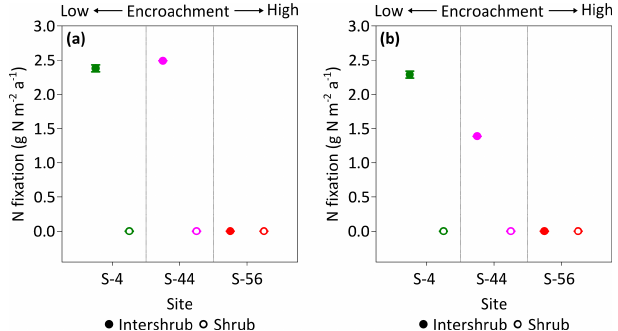
Figure 9. Median rates of asymbiotic nitrogen (N) fixation for inter- shrub and shrub surface (top 10cm) soil (a) and inter-shrub and shrub surface soil weighted by area cover (b) along a gradient of shrub encroachment in the Santa Rita Experimental Range, AZ, US ( n = 3). Error bars represent median absolute deviation about the median. N fixation rates were determined using the acetylene re- duction assay method in which ethylene was converted to N 2 using a 3 : 1 ratio (Telling et al., 2011). Results are reported on a dry mat- ter